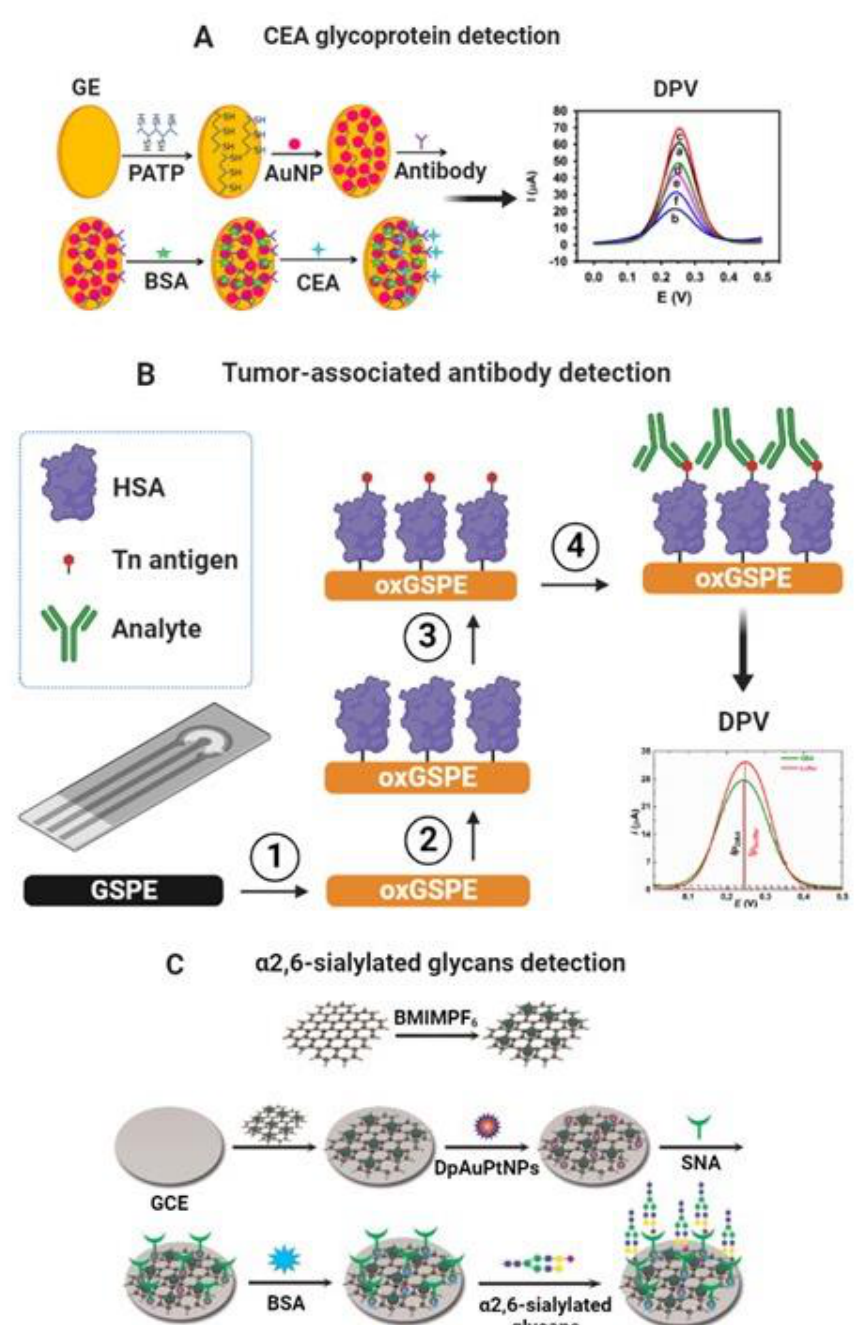
Figure 4. ( A ) Scheme of the different steps involved in developing a label-free nanoimmunosensor for CEA detection. (a) Bare gold electrodes and modified with (b) PATP, (c) PATP–AuNPs, (d) PATP–AuNPs–anti-CEA, (e) PATP–AuNPs–anti-CEA blocked with BSA, and (f) PATP–AuNPs–anti-CEA incubated with CEA after being blocked with BSA. Adapted from [98] with permission. Copyright Elsevier 2013. ( B ) Modification of graphene screen-printed electrode (GSPE) by electrochemical oxidation (step 1), covalent immobilization of human serum albumin (HSA) as a natural nanoscaffold (step 2), and covalent immobilization of a Tn antigen to HSA (step 3). The final step is incubation with the analyte protein (step 4) [135]. ( C ) Schematic representation of the electrochemical biosensor based on GCE modified with rGO-EPA/BMIMPF 6 /AuPtNPs. Reproduced from [142] with permission. Copyright Elsevier